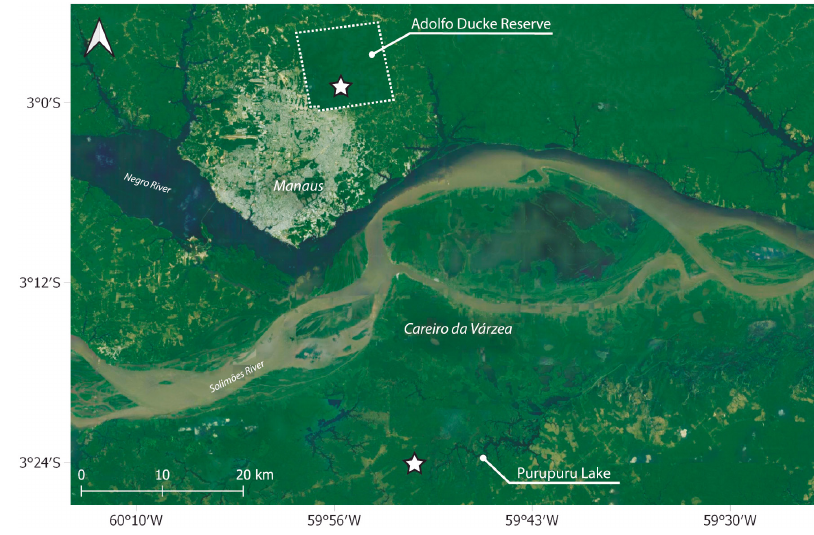
FIGURE 1 | Sampling areas (Adolpho Ducke Reserve and Purupuru Lake, Amazonas, Brazil) where individuals of Electrophorus varii were captured. The white stars represent the exact sampling